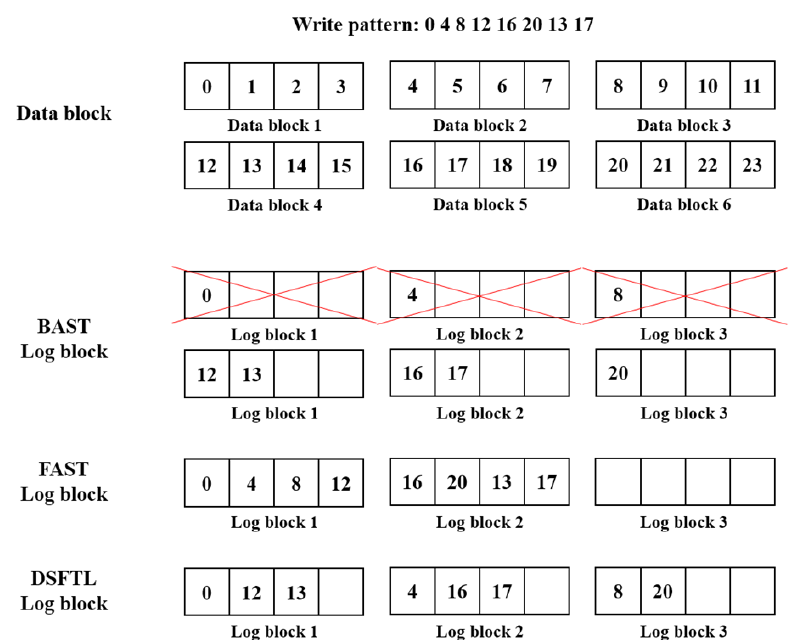
Figure 6. When data in a data block is written to a log block.